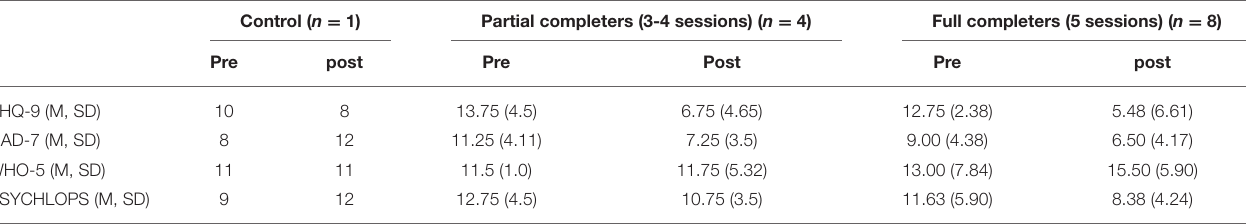
TABLE 4 | Means and SDs of clinical outcomes before and after intervention for control, partial completers and